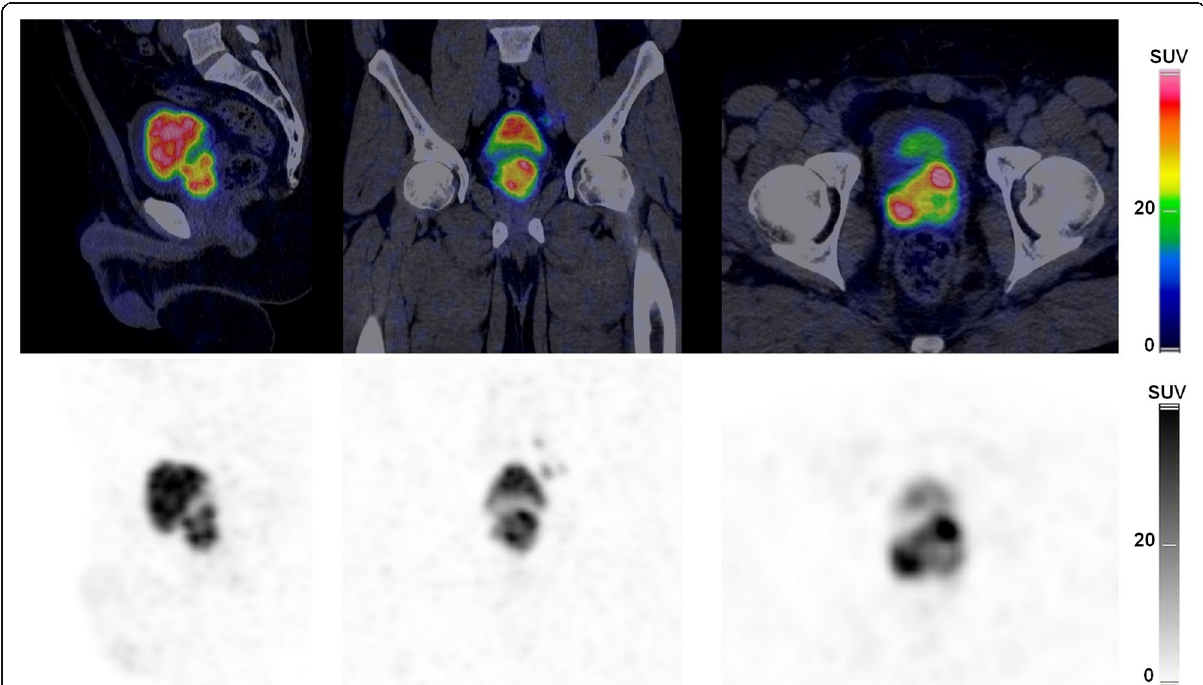
Fig. 3 The PET/CT images show a case of observers agreement on diffuse [ 68 Ga]Ga-PSMA-11 uptake in the prostate gland but discordance of the number of prostate primary lesions: one left focus and one right focus were described by observers #1 and #2 while two left foci and three right foci were detected by observer